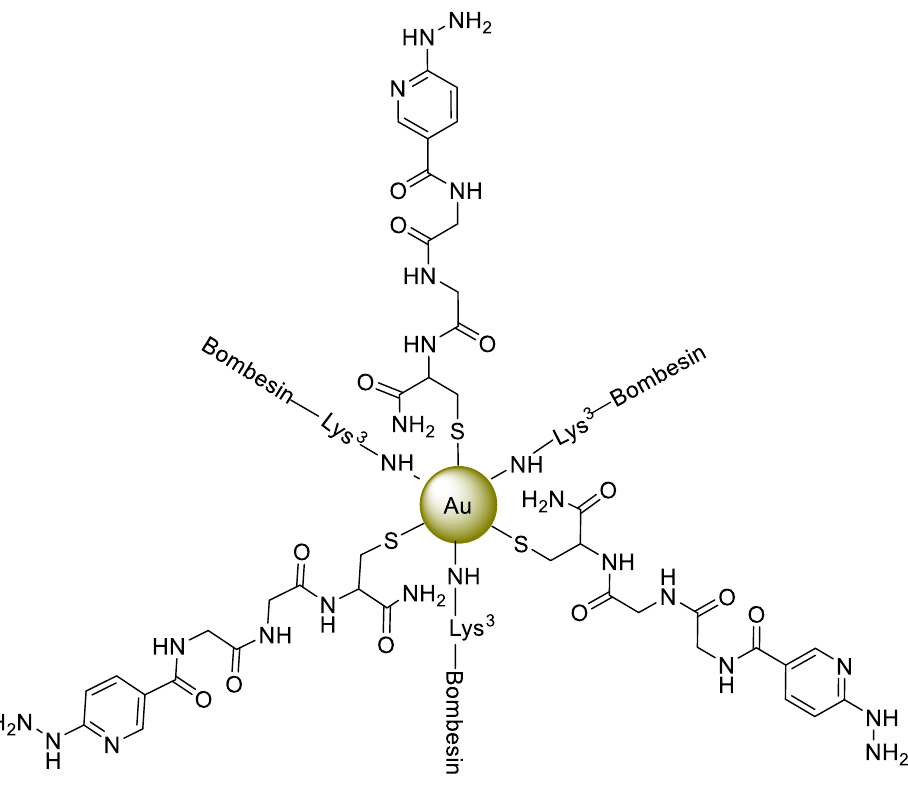
Figure 4. A HYNIC-GGC-AuNP-Lys 3 -bombesin core for 99m Tc radiolabeling [35].